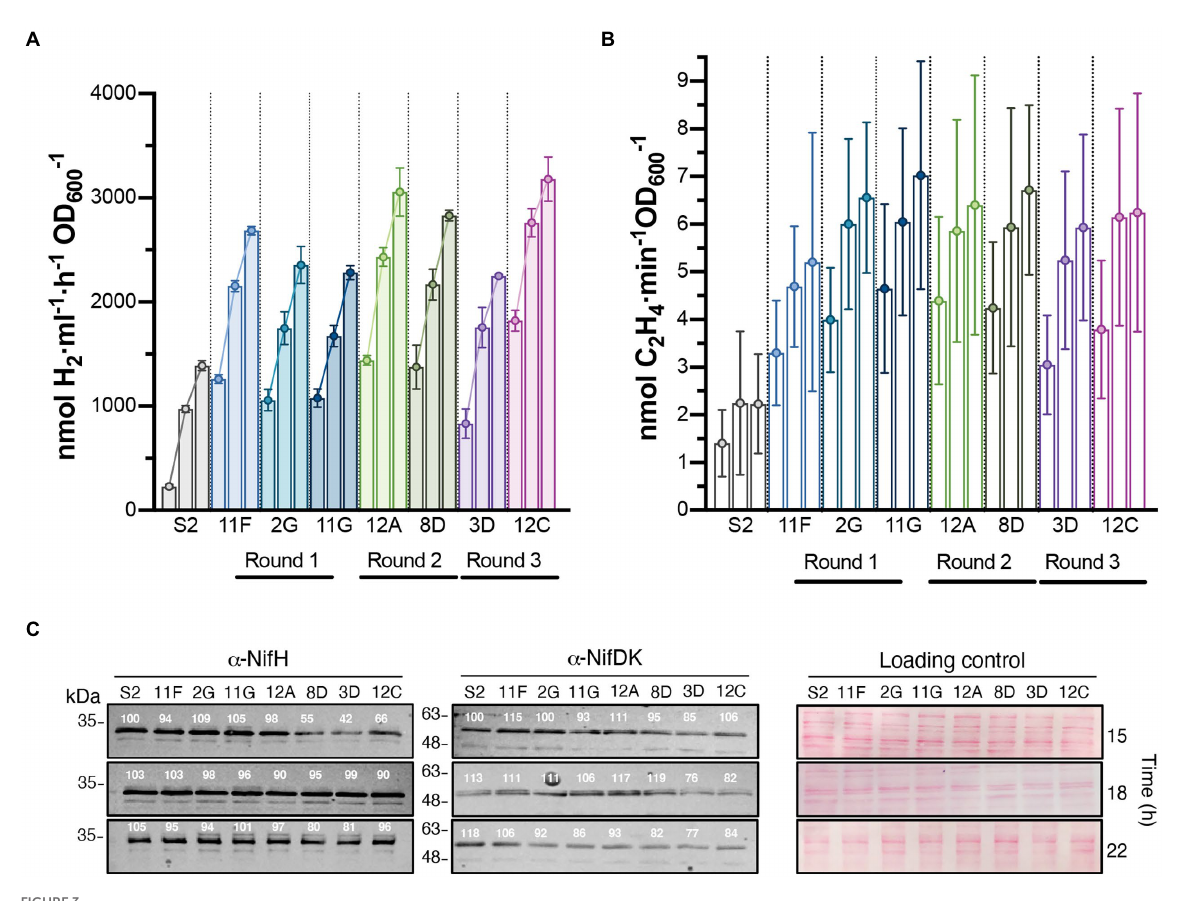
FIGURE 3 Time course of H 2 production in batch cultures of selected strains isolated after each round of UV mutagenesis. In vivo H 2 (A) and ethylene (B) production of S2 and the highest H 2 overproducing variants. The three bars of each strain represent activities at 15, 18, and 22 h after the start of nitrogenase depression. Data represent the mean ± SD of biological replicates ( n = 6 for H 2 , n = 4 for ethylene). Each biological replicate had 2 technical replicates. Statistically significant differences in H 2 production between S2 and H 2 overproducers existed at all measured times ( p < 0.0001). Differences in ethylene production between S2 and H 2 overproducers were statistically significant at 22 h ( p < 0.05). (C) Immunoblot detection of nitrogenase NifH and NifDK components in cell-free soluble extracts from cultures shown in panel B. Normalized quantification of band intensity is indicated above each band. Ponceau staining of membranes is shown as loading control. Full uncropped gels are available as Supplementary Figure